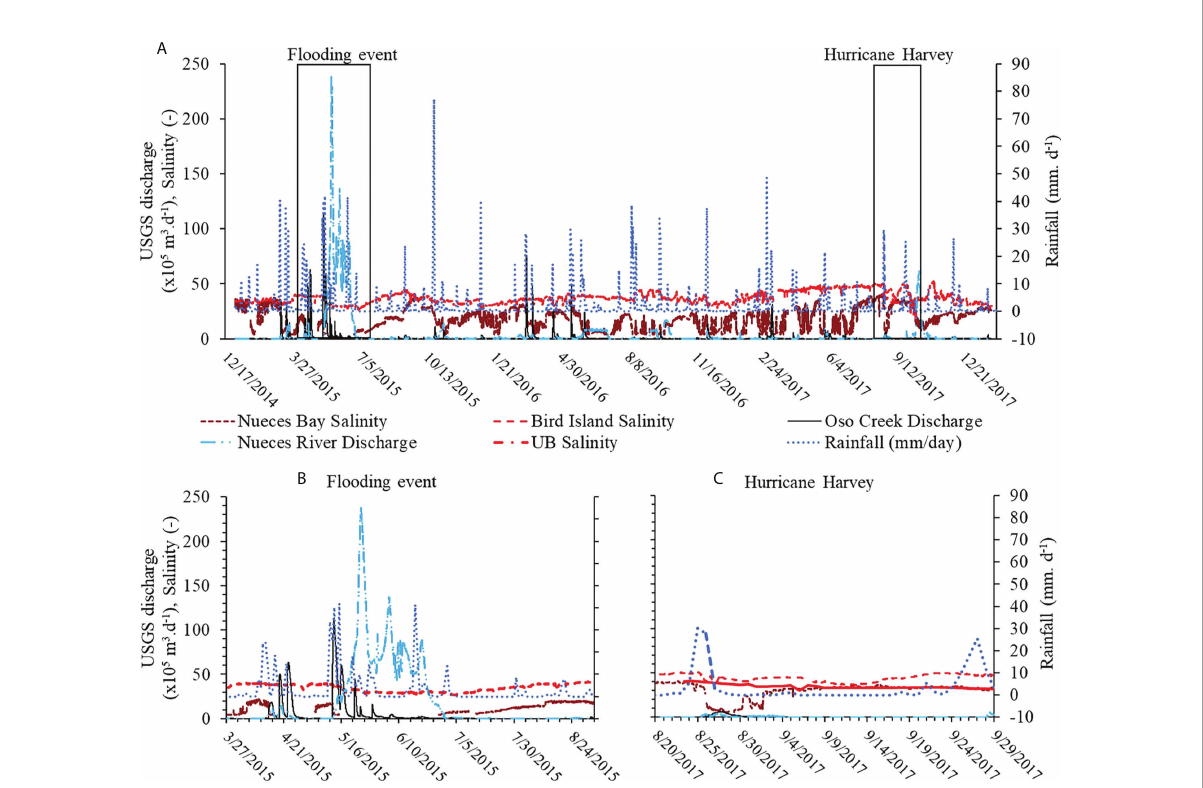
FIGURE 2 United States Geological Survey (USGS) stream fl ow discharge for Oso Creek at Corpus Christi, TX (08211520) and Nueces River at Calallen, TX (08211500), salinity (Nueces Bay: NUDE3, 043; Bird Island: NPSBI, 171), and precipitation depths recorded near the study area between 2015 - 2017 (A) with closer looks at (B) the 2015 fl ood event and (C) Hurricane